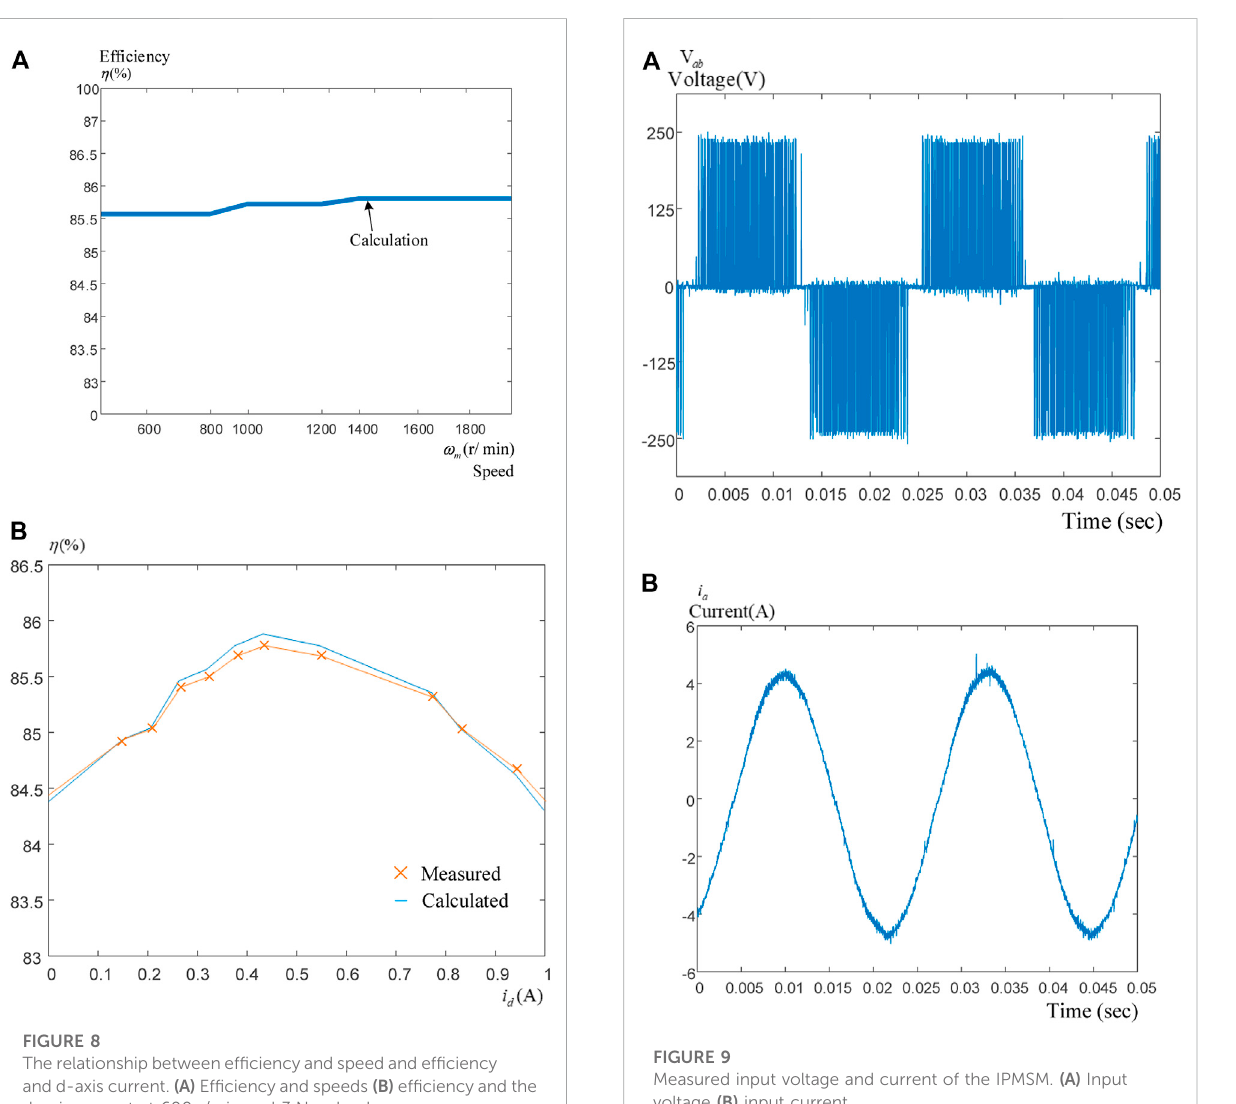
FIGURE 9 Measured input voltage and current of the IPMSM. (A) Input voltage (B) input